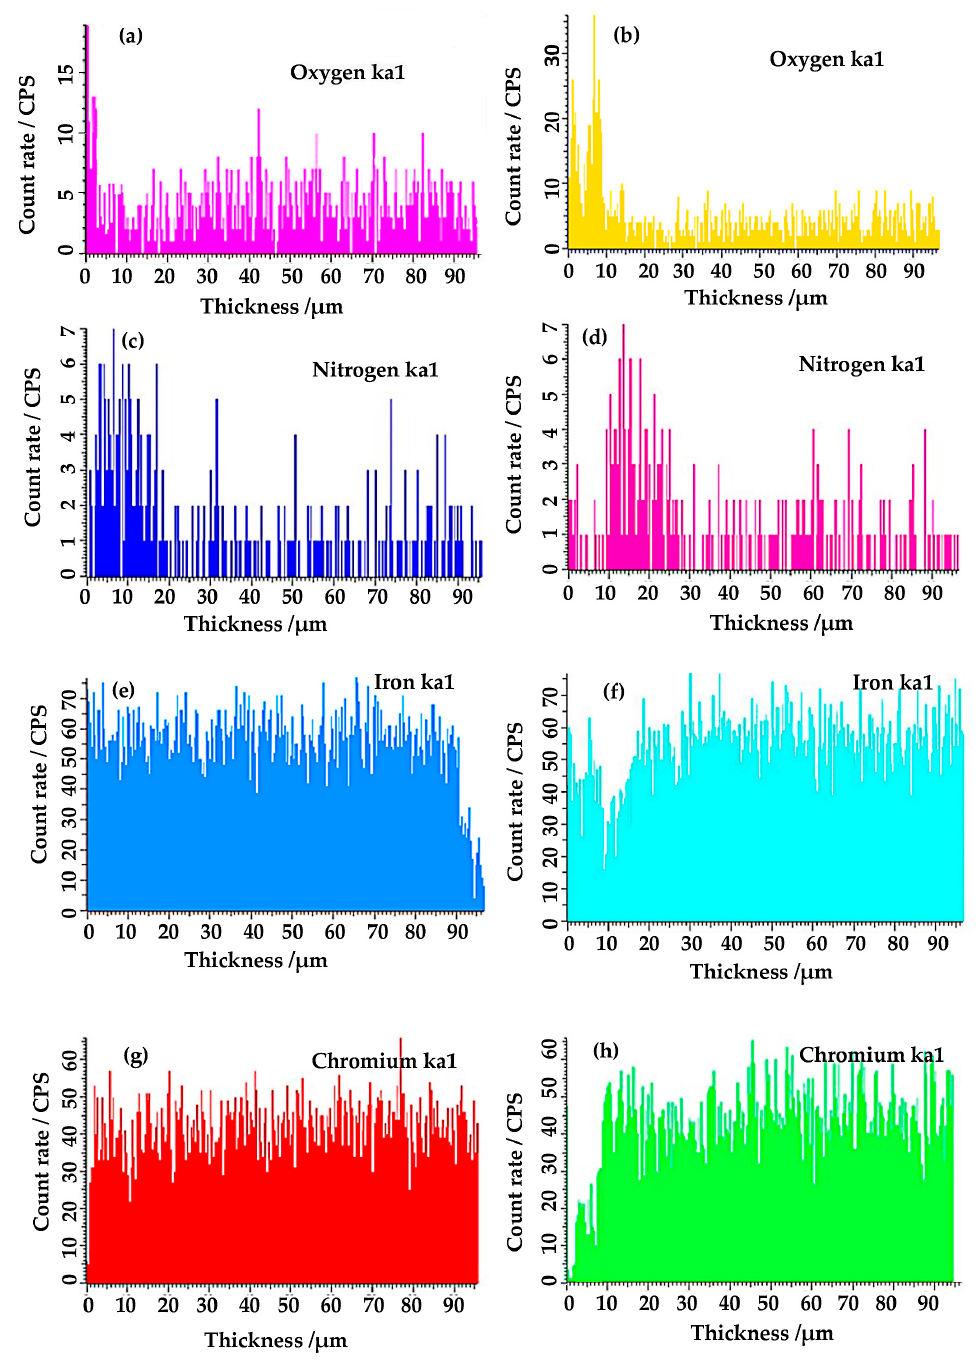
Figure 4. EDS analysis results (from surface to the center): ( a , c , e , g ) of 570 °C nitriding sample; ( b , d , f , h ) of 610 °C nitriding sample.